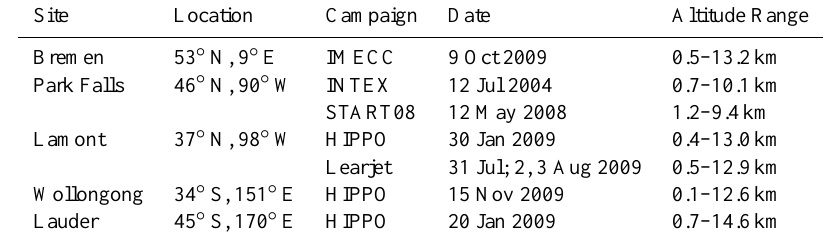
Table 3. Aircraft Overflights. TCCON site locations and aircraft campaign dates and altitude ranges are listed.